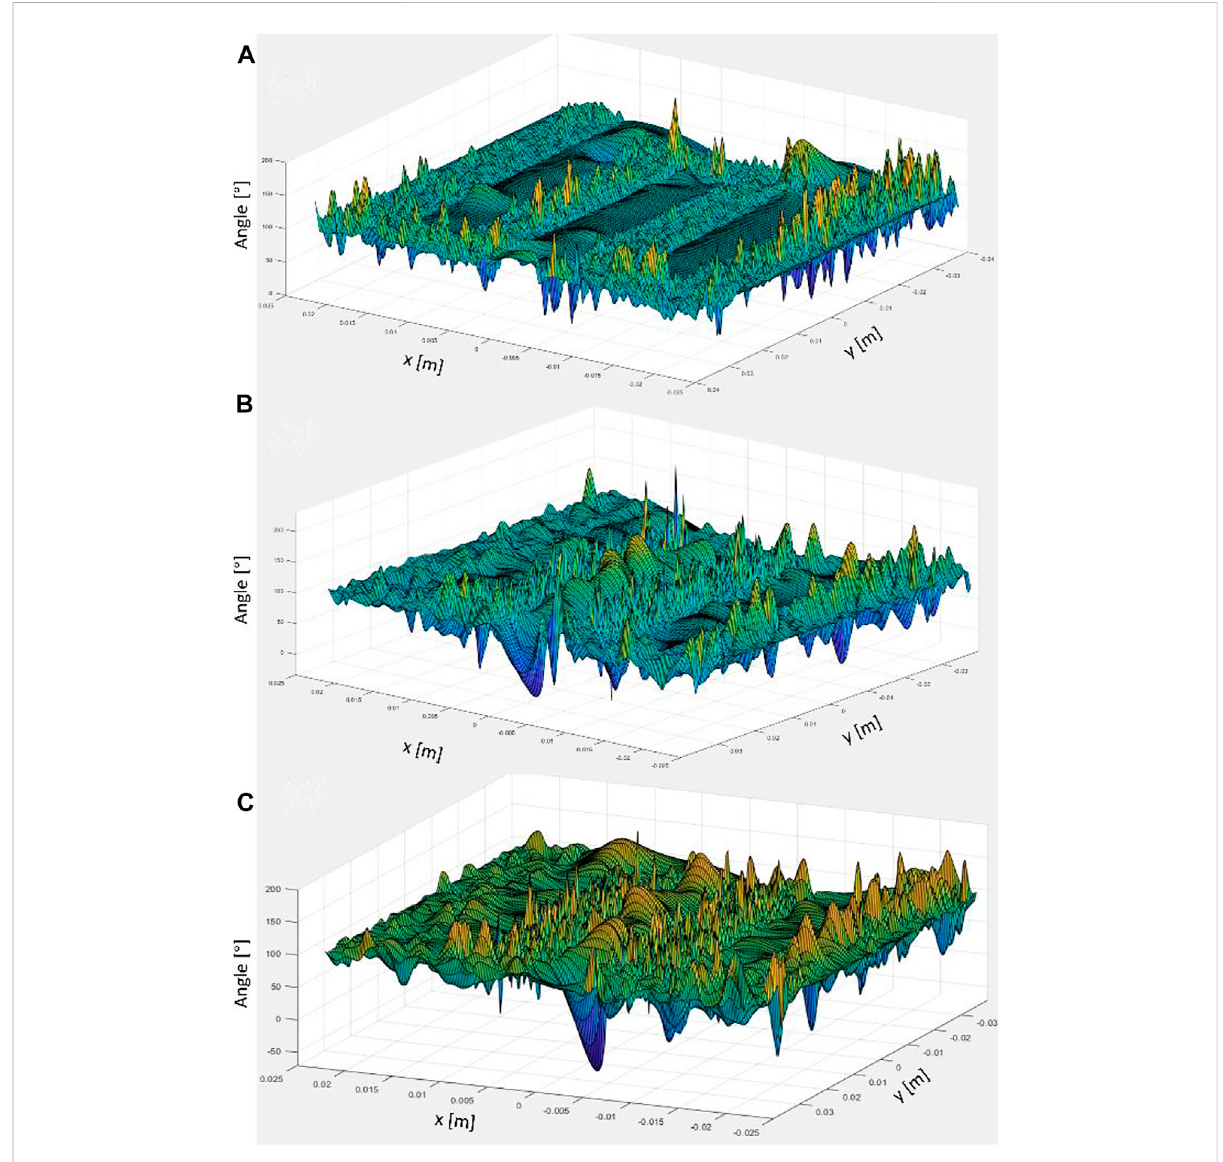
Comparison of fi eld phase coordination angles with different fi n